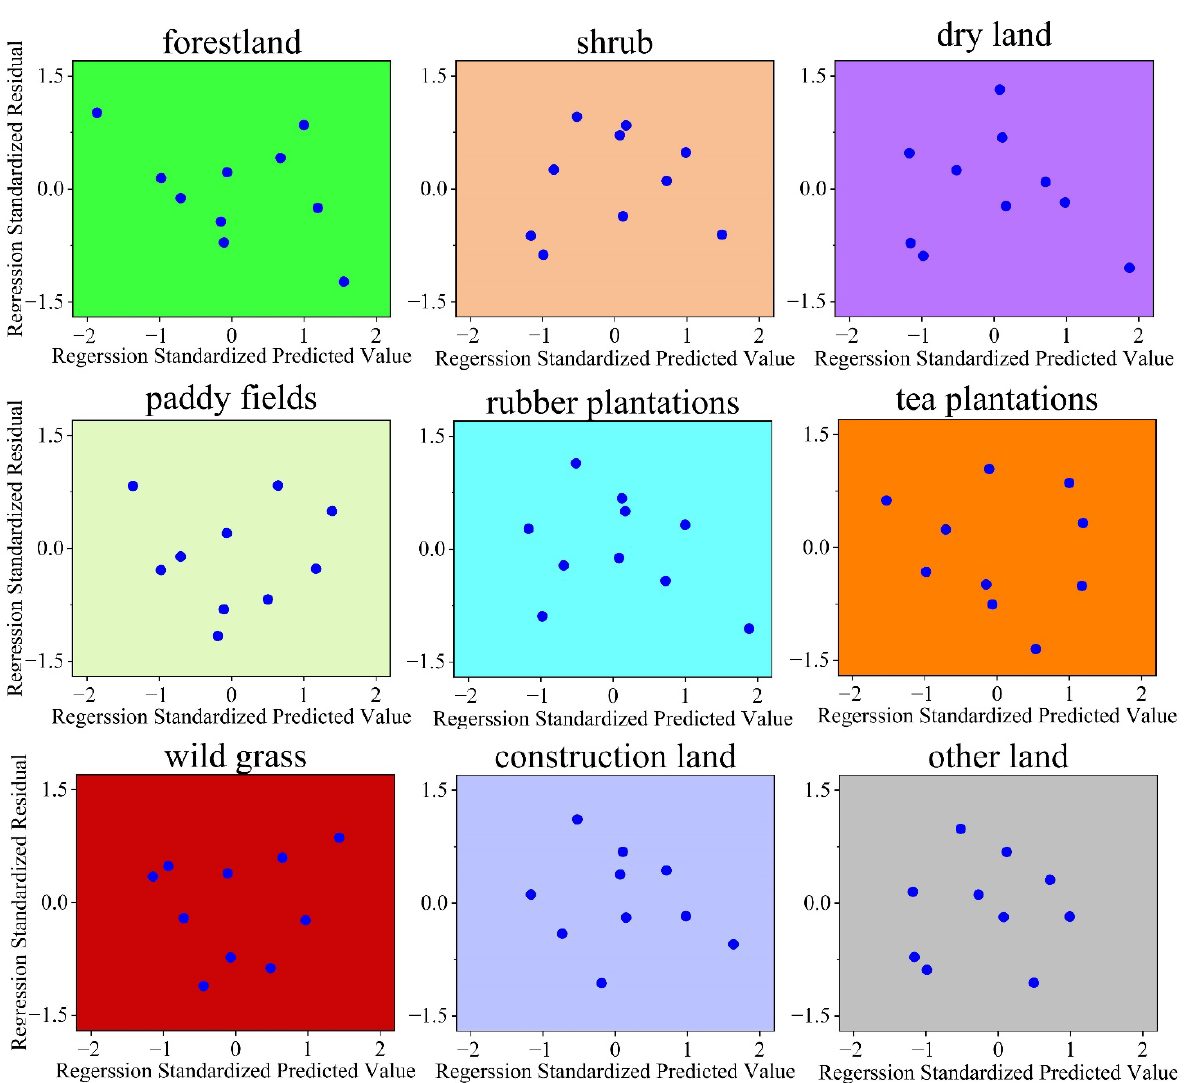
Figure 5. The results of regression standardized residual versus regression standardized predicted values are shown in the figure above. It can be seen that the residuals of each regression equation are randomly distributed around the interval of ( − 2, 2), and thus the residuals meet normality and inde- pendence. As a result, these stepwise linear regression equation models pass significance